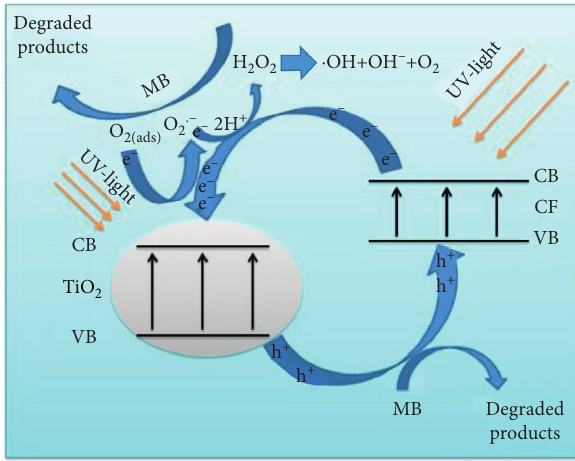
Scheme 1: Mechanism diagram of photocatalytic reaction of MB under